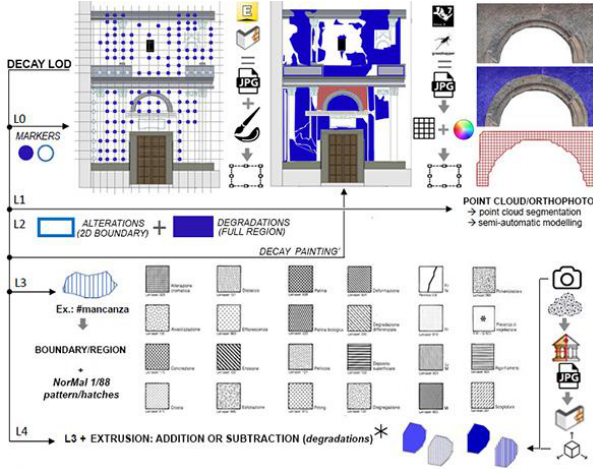
Figure 5 . Five level of detail in decay representation: L0 L1, L2, L3, L4 between iconic and reality-based